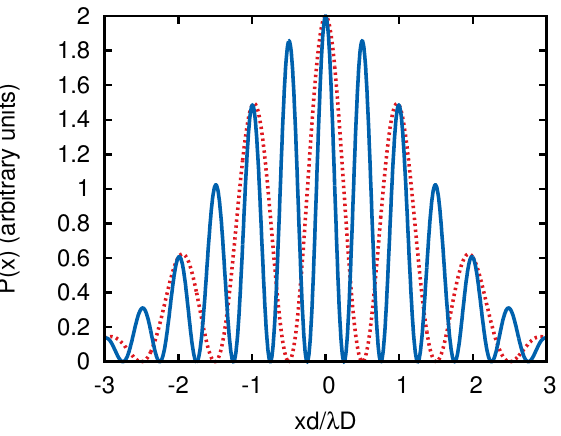
Figure 3: Double-slit interference pattern of the biphoton given by (18), where λ is the wavelength of the photons (solid line). Fringe width is w = ( λ/ 2) D . Double-slit interference pattern of d the photons given by (20) (dotted line). Fringe width is w = λ D A typical profile of f ( x ) has been used for the